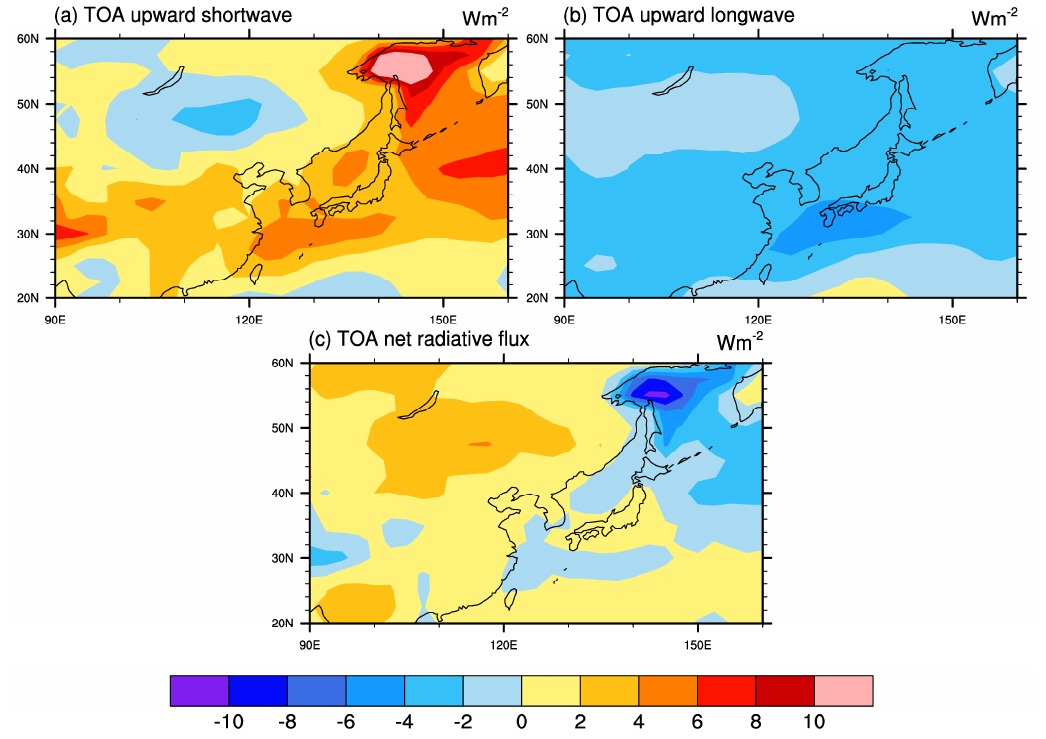
Figure 2. ( a ) top of the atmosphere (TOA) upward shortwave radiation, ( b ) TOA upward longwave Figure 2. Same as Figure 1, except for over East Asia. radiation, and ( c ) TOA net radiative flux between G4cdnc and RCP4.5 during the progress period. Results are shown for multi-model ensemble mean, over East